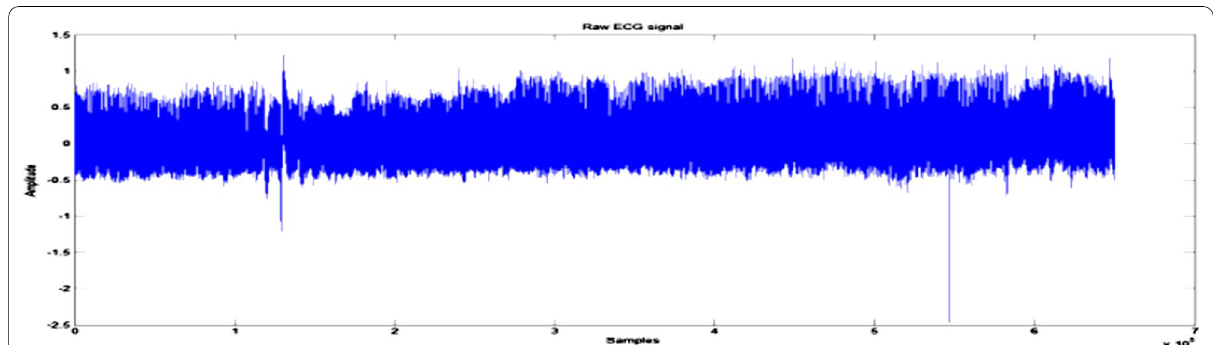
Fig. 7 Raw ECG record number 100: The figure represents a normal ECG signal having normal heart rate from MIT-BIH arrhythmia database